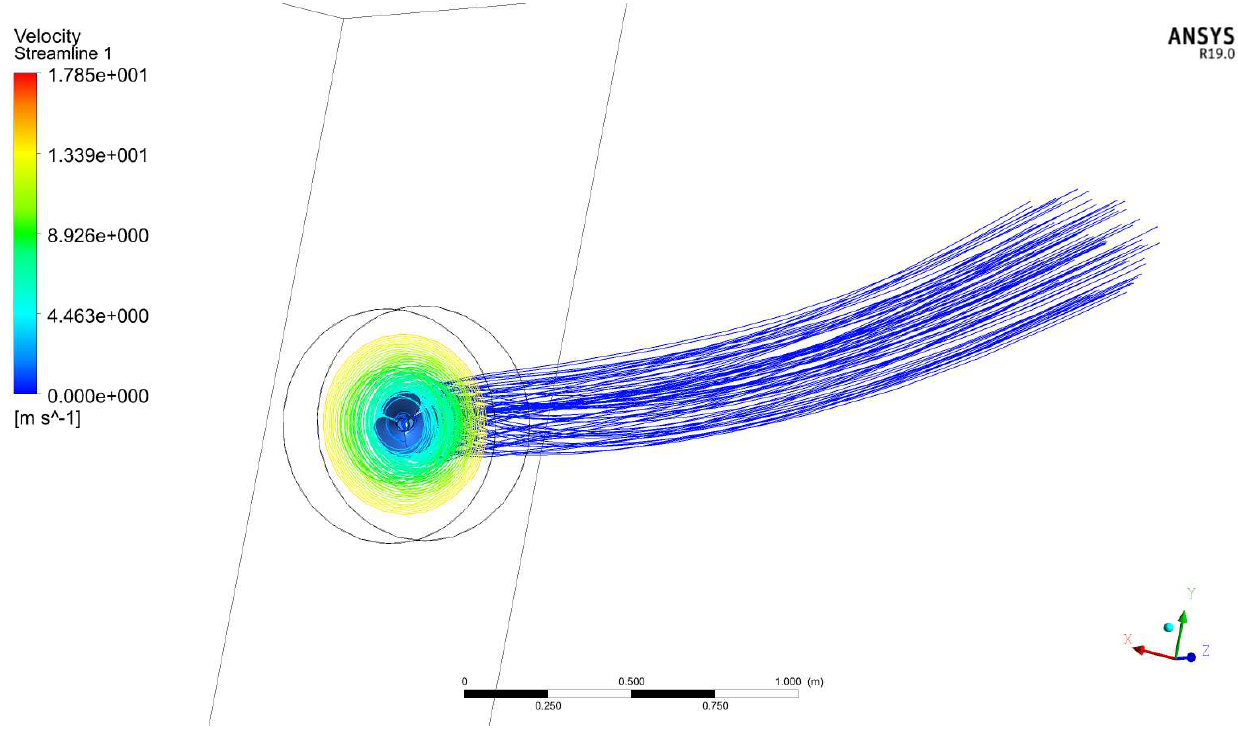
Figure 18. Velocity variations of 400 RPM.